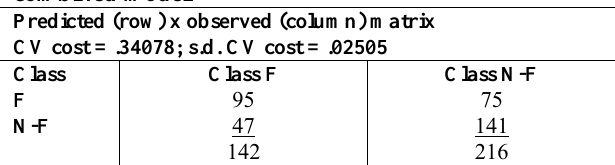
Table 7: Test sample misclassification matrix for combined model